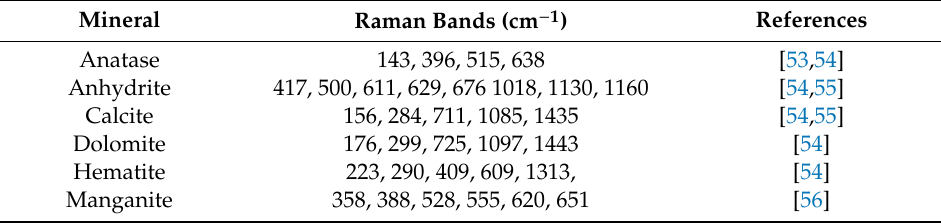
Table 1. Minerals in the Lotsberg Salt Formation (LSF) with diagnostic Raman